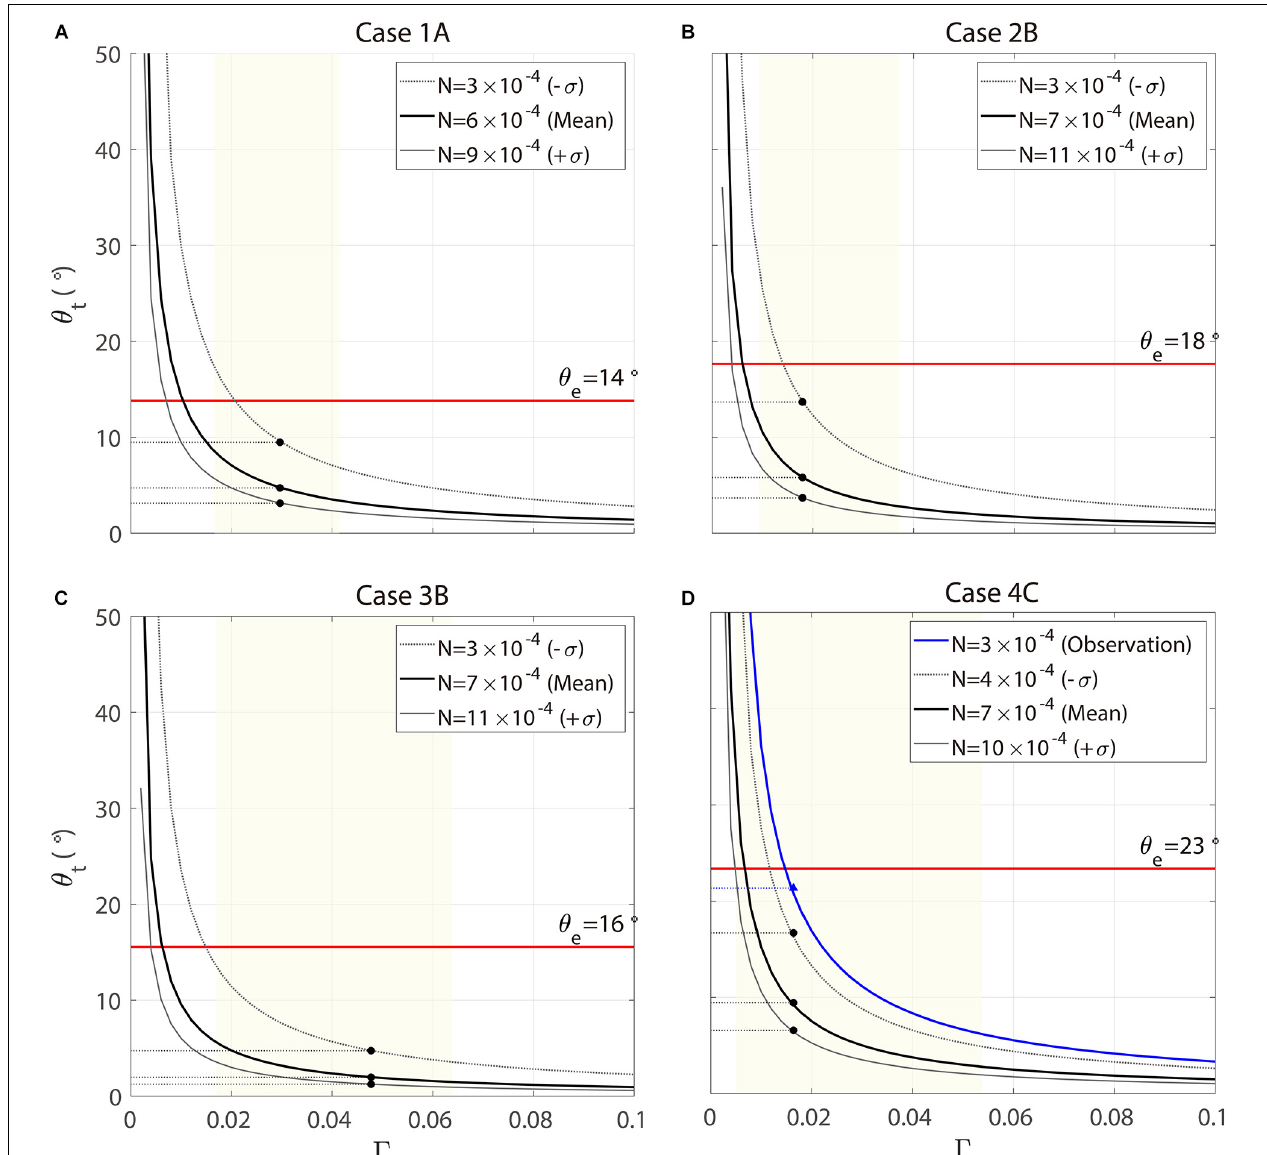
FIGURE 9 | Sensitivity analysis for TRW parameters with bottom slope and buoyancy frequency for (A) Case 1A, (B) Case 2B, (C) Case 3B, and (D) Case 4C. The horizontal red line denotes the estimated angle ( θ e ), and black dots denote the corresponding slope of the predicted angles of that grid for the mean and one standard deviation above and below the mean buoyancy frequency from the HYCOM reanalysis data (gray, gray dashed, and black lines, respectively). The adjacent slope range to each grid is shown for the yellow-shaded areas. For Case 4C, the blue line denotes the mean buoyancy frequency from the observed CTD